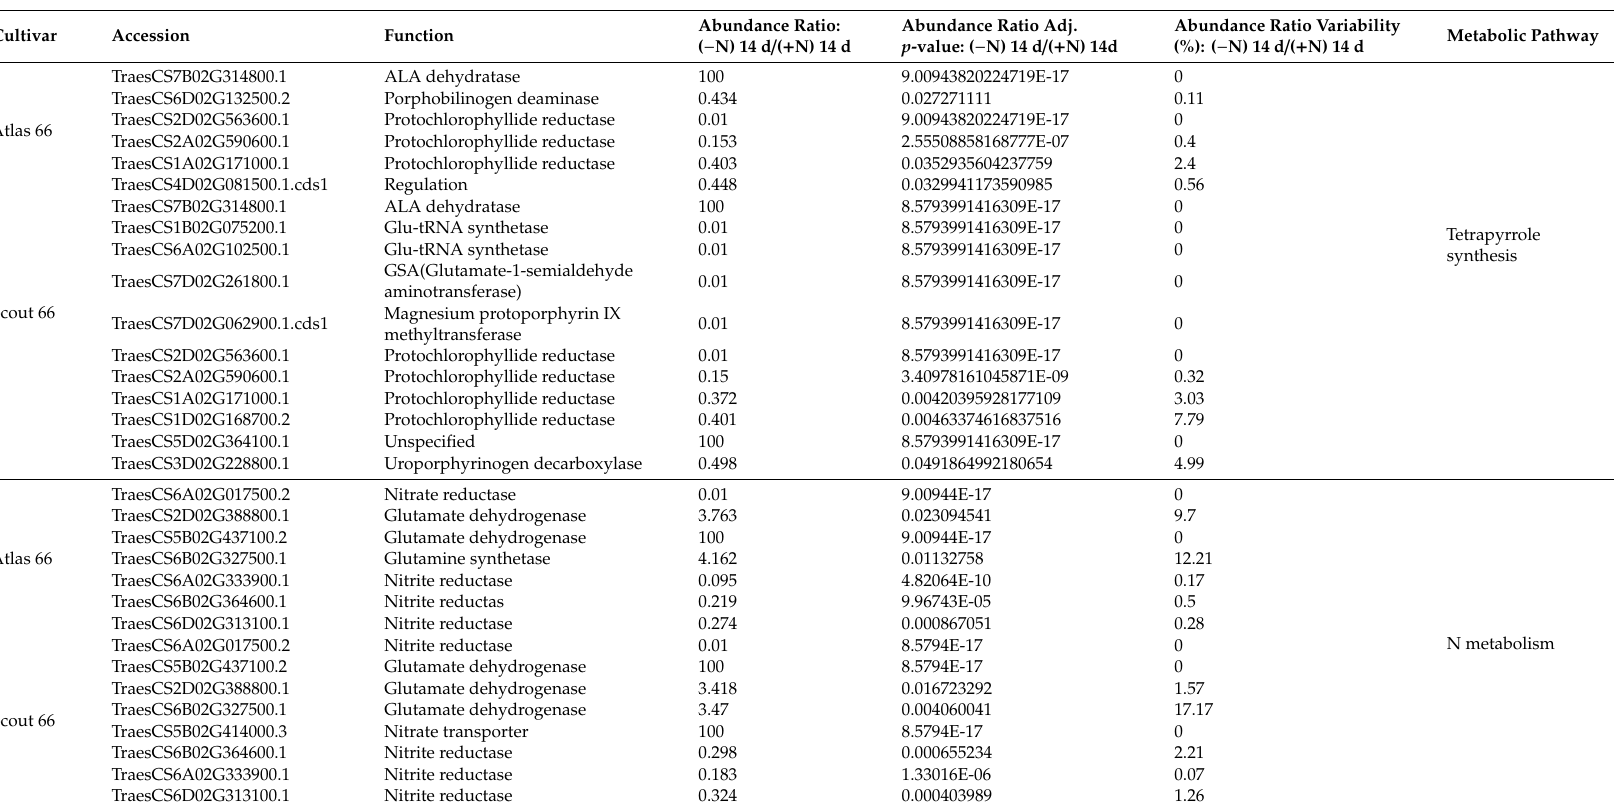
Table 1. Di ff erential accumulated proteins (DAPs) of Atlas 66 and Scout 66 enriched in tetrapyrrole synthesis, N metabolism, secondary metabolism flavonoids, and sulfate